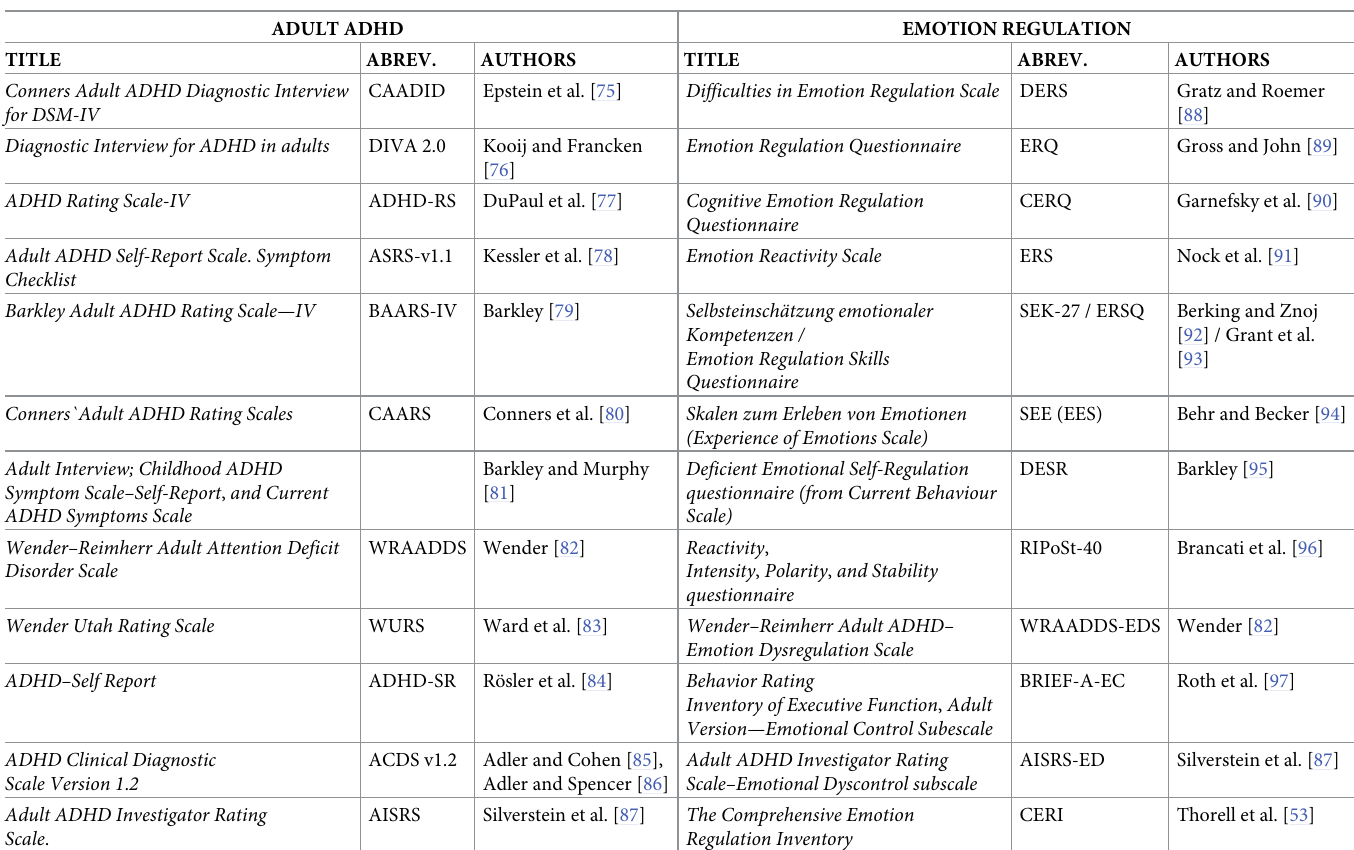
Table 2. Assessment tools used in the articles reviewed. ADULT